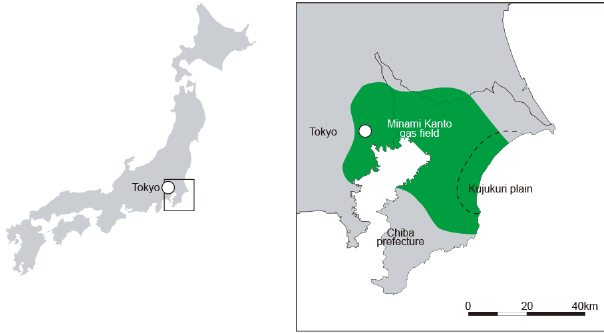
Figure 1. Minami kanto gas field.